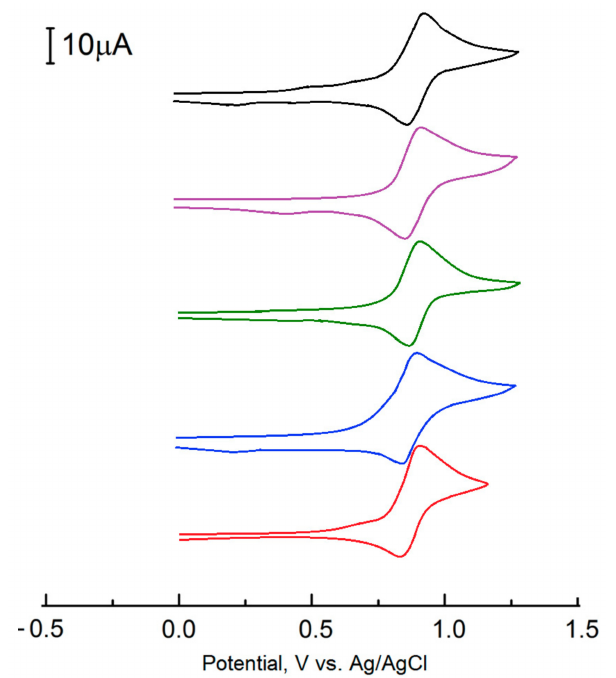
Figure 4. Cyclic voltammogram of 5a (red), 5b (blue), 5c (green), 5d (violet), 5e (black) oxidation and re-reduction (1 mM) in CH 3 CN, Bu 4 NBF 4 (0.1 M), reference electrode (RE) Ag/AgCl, scan rate 100